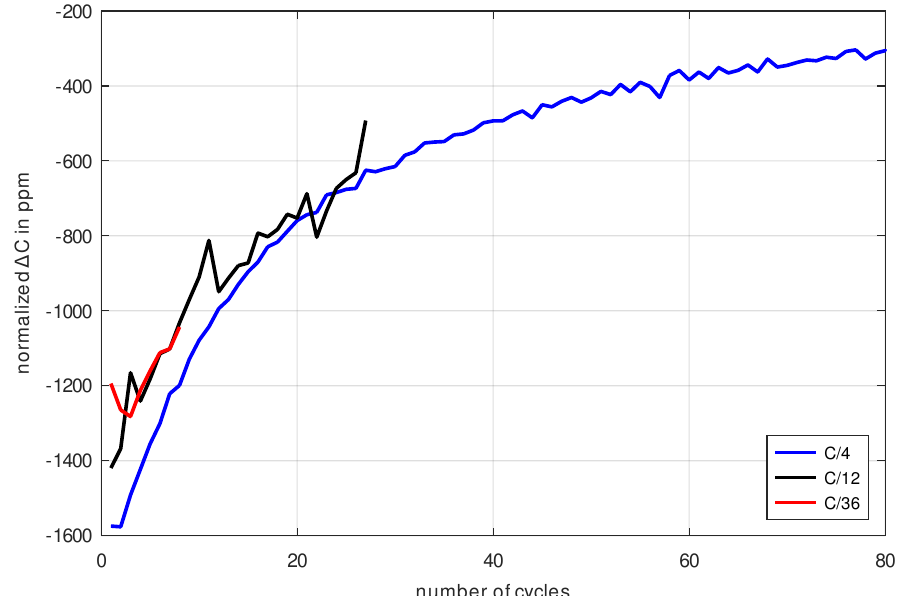
Figure 13. Capacity degradation at cycling current C/4, C/12 and C/36 at 40 °C. This capacity degradation in the C/x-schemes corresponds to the cycle aging of the cells. Because all aging rates are approximately equal at given cycle, it is concluded that the cells have a more or less current- independent cycle aging rate (at least for the selected magnitude of the cycling currents).